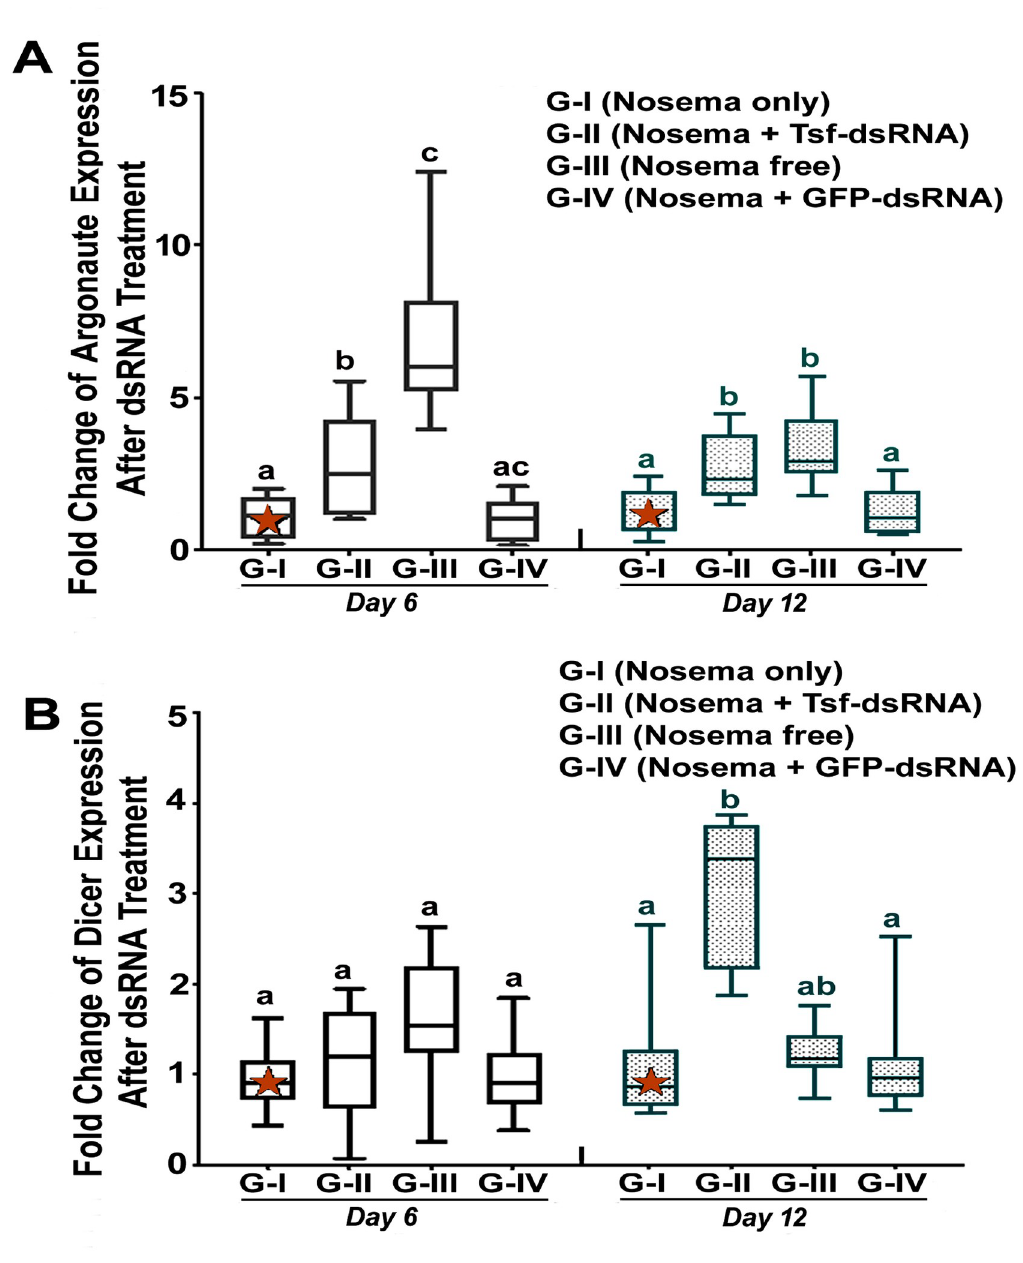
Fig 10. Transcript levels for RNA-induced silencing complex components. (A) Argonaute . (B) Dicer . The relative expression was expressed as an n-fold difference relative to the calibrator (marked by a star) by 2 – ΔΔ Ct method. A star denotes a calibrator and the different lower-case letters above bars indicate the statistically significant difference among different groups ( P � 0.05, ANOVA and Tukey´s